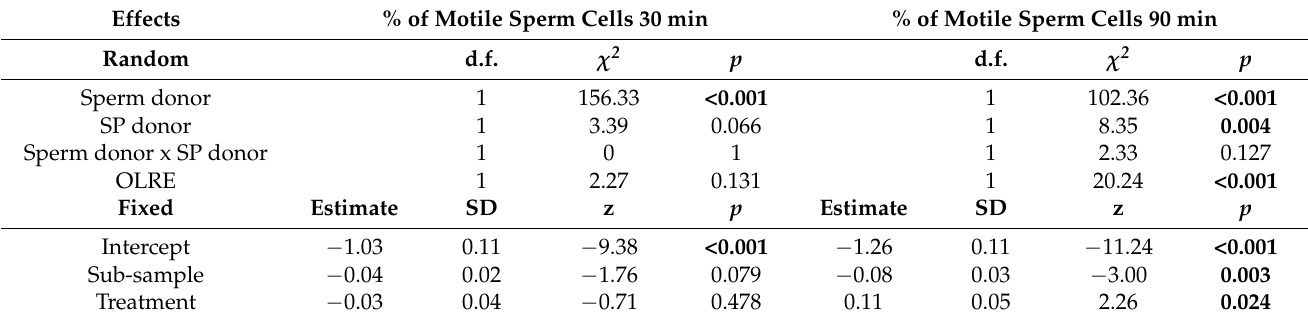
Table 1. Generalized linear mixed model (GLMM) statistics for the effect of sperm donor, SP donor, and their interaction (random effects) on the proportion of motile sperm cells at two time points (30 and 90 min) after the initiation of the SP treatment. Models also included fixed effects of sub- sample and treatment (own or foreign SP). OLRE = observation-level random effect.